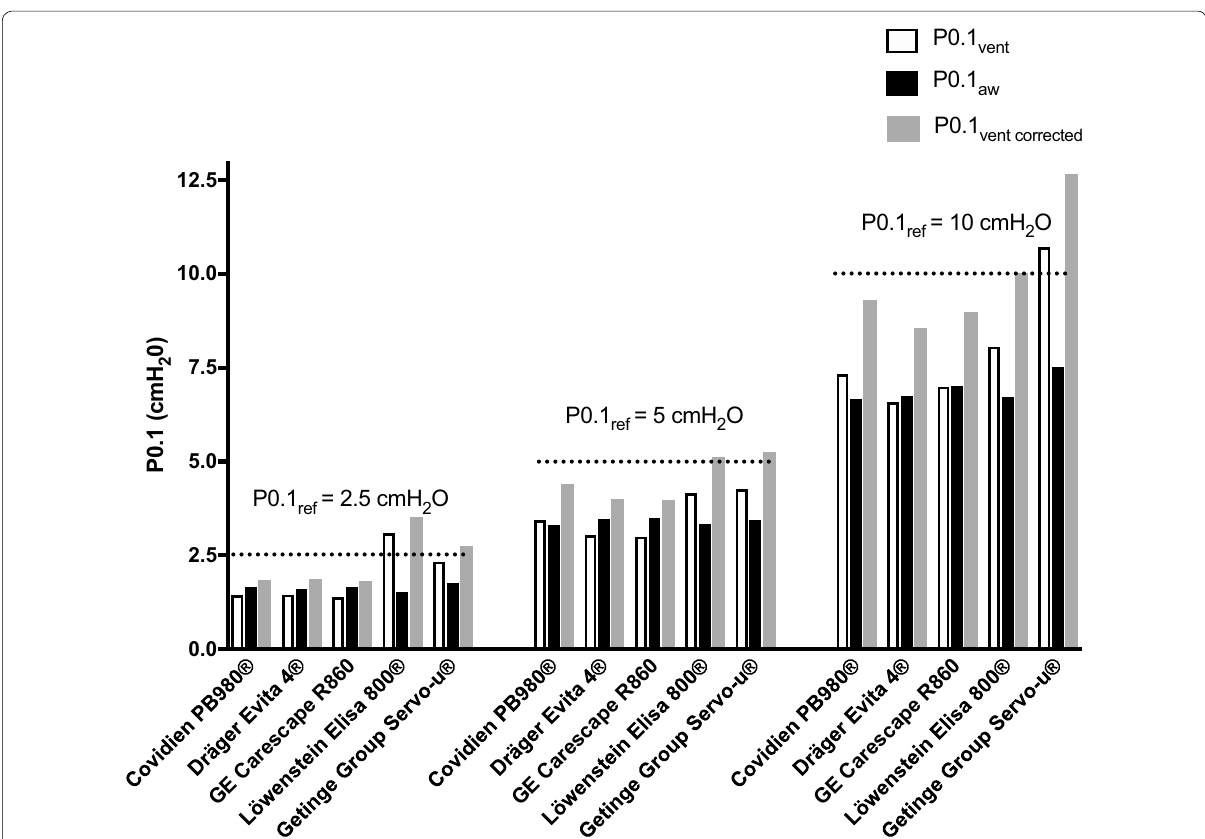
Fig. 5 Automatically measured P0.1 displayed by the ventilator (P0.1 vent ), P0.1 measured on the airway pressure during automated P0.1 measurement (P0.1 aw ) and P0.1 measurement corrected for the occlusion location (P0.1 vent corrected ). P0.1 vent corrected ∆P0.1 circuit corresponding to the difference between P0.1 circuit measured with an occlusion performed at 360 cm from the airway opening and P0.1 ref (reference P0.1) measured with an occlusion performed at the airway